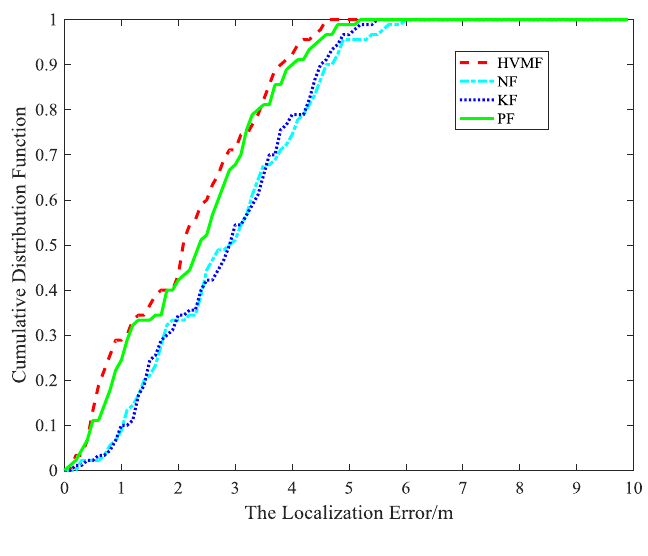
Figure 15. The localization error CDF.